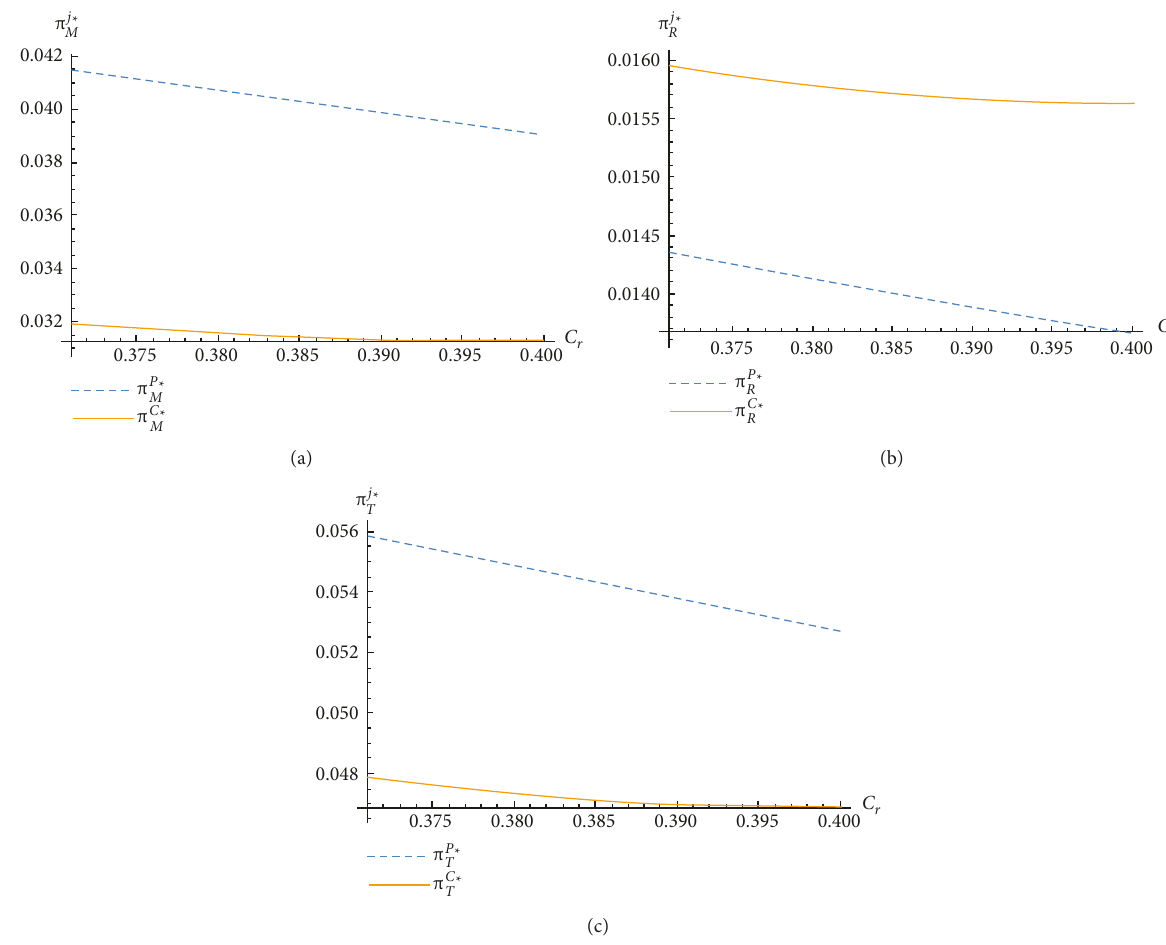
j ∗ r on π M ; (b) effects of